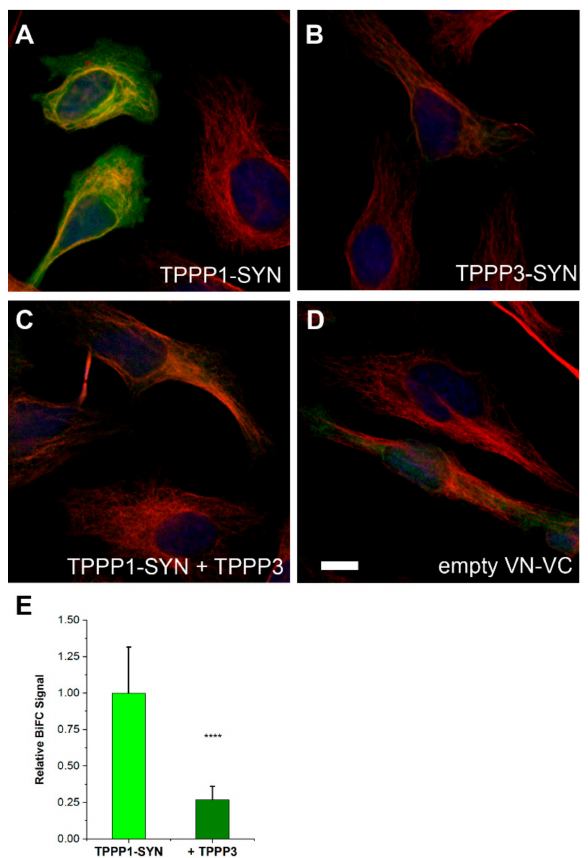
Figure 9. The effect of TPPP3 on the association of TPPP1 and SYN in living human cell model. ( A , B ) The associations of SYN and TPPP1, but not that of TPPP3, are visualized by BiFC technology. The cells were co-transfected with TPPP1 and SYN ( A , C ) or with TPPP3 and SYN ( B ) fused to mVenus, or with empty mVenus ( D ) BiFC constructs; the microtubule network was stained with Alexa546 (red). ( C ) In a competition experiment, cells were co-transfected with unlabeled TPPP3 simultaneously with the Venus constructs of TPPP1 and SYN. Nuclei are counterstained with Hoescht 33342 (blue). Scale bar: 5 µ m. ( E ) Quantification of the BiFC signal by detecting the fluorescence intensity of the cells without and with TPPP3. Data were compared by two-sided, unpaired Student’s t -test, **** p <